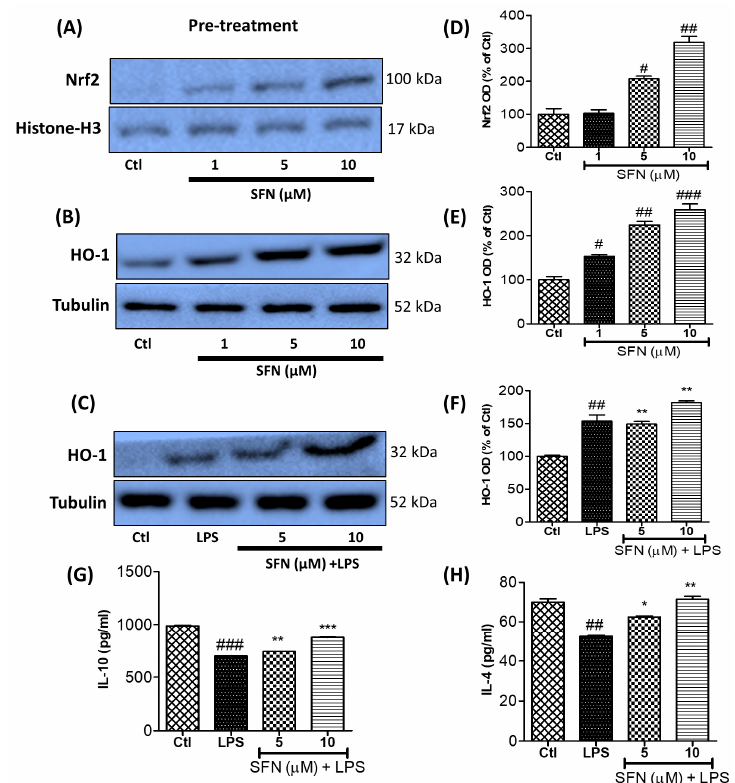
Figure 8. SFN increased the expression of the anti-inflammatory proteins Nrf2 and HO-1 and the anti-inflammatory cytokines IL-10 and IL-4 in BV2 microglial cells. The cells were pre-treated with SFN for 30 min and then stimulated with LPS (100 ng/mL). After 3 h and 12 h of LPS incubation, the cells were harvested and the expressions of Nrf2 and HO-1, respectively, were determined using western blot analysis. ( A – F ) Quantification of the Nrf2 and HO-1 expression levels. BV2 cells were pre-treated with SFN, followed by LPS (100 ng/mL) activation for 24 h. The conditioned medium was collected from the treated cells and stored for ELISA evaluation. ( G – H ) Secreted levels of IL-10 and IL-4, evaluated by competitive ELISA. All data are presented as the mean ± standard error of the mean of three independent experiments. * p < 0.05, ** p < 0.01, and *** p < 0.001 indicate significant differences compared with LPS treatment alone; # p < 0.05, ## p < 0.01, and ### p < 0.001 indicate significant differences compared with the untreated control group. Ctl—untreated control cells; LPS—cells treated with lipopolysaccharide only.